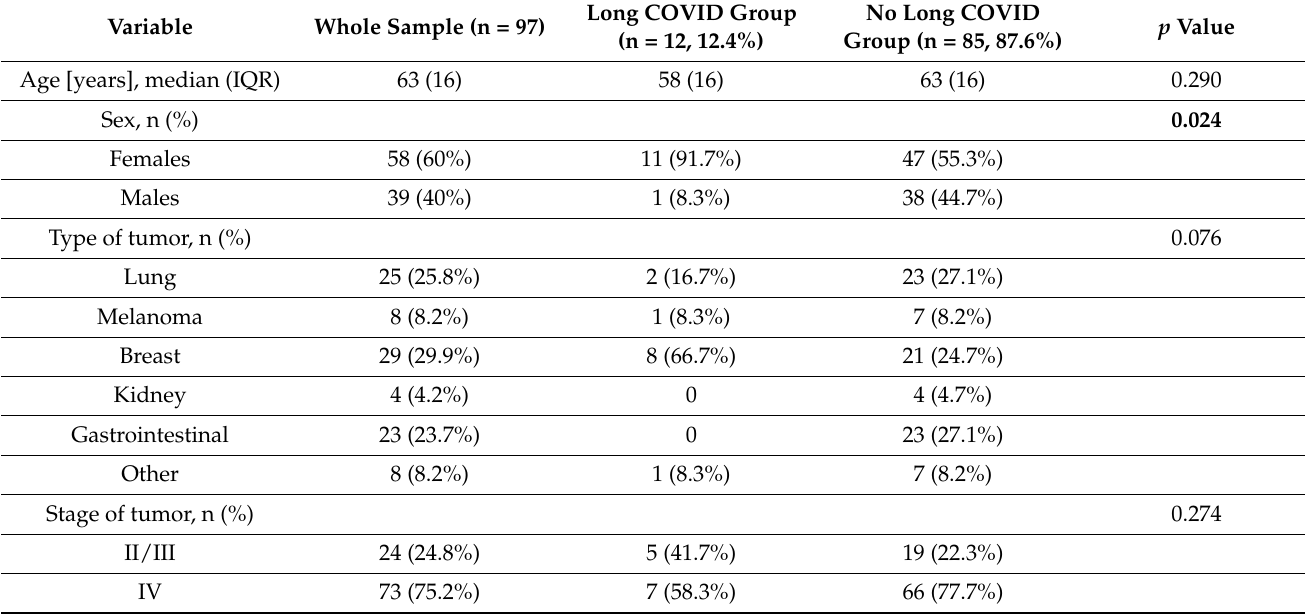
Table 2. Clinical and demographic characteristics of cancer patients enrolled with telephone follow-up (whole sample and grouped by presence of long